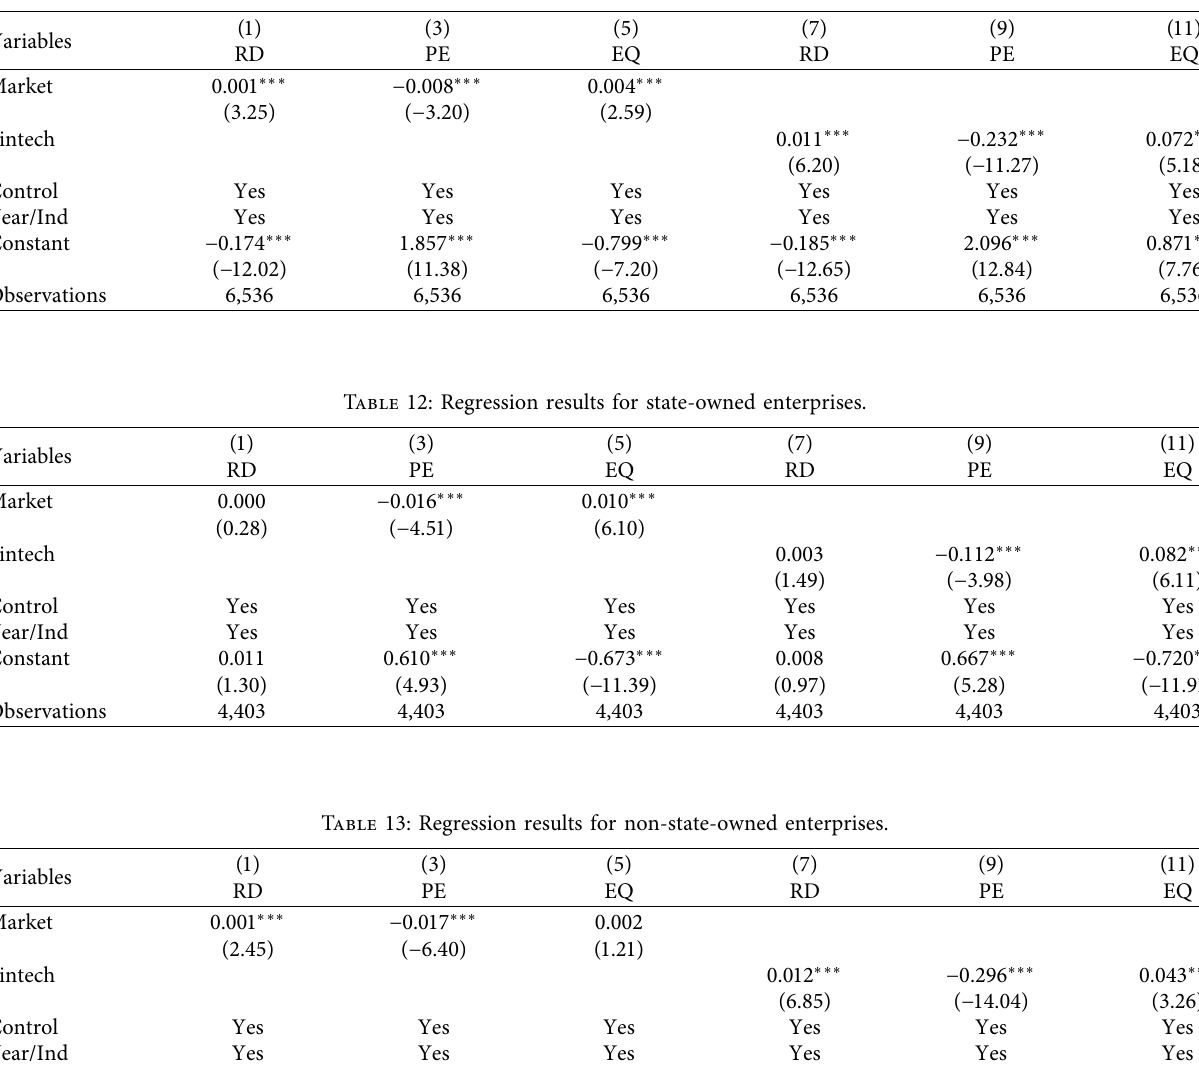
Table 11: Regression results for small-scale enterprises.